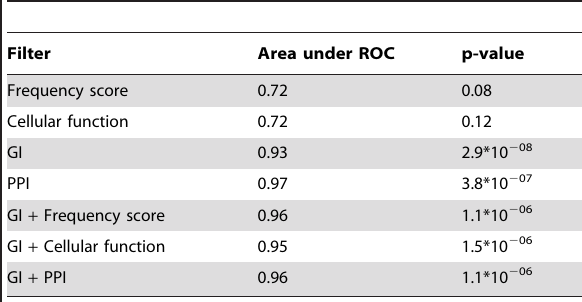
Table 3. Statistical comparison of the efficacy of different minimotif filters and filter combinations.